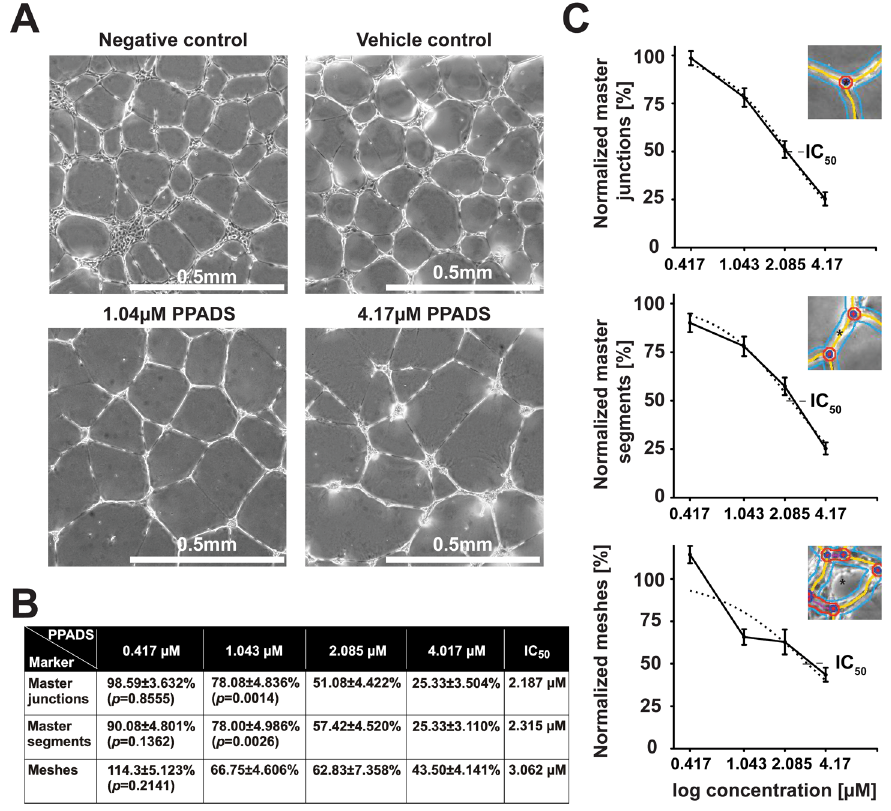
Figure 1. PPADS inhibits formation of tubes by HUVECs. A ) Representative phase contrast images of tubes formed in the absence of supplements (negative control), in the presence of vehicle (0.9% NaCl) or vehicle plus 1.04 m M PPADS or 4.17 m M PPADS. B ) Tabular summary of mean values 6 SEM of master junctions, master segments and meshes in cells incubated with the indicated concentration of PPADS and calculated IC 50 for each marker. C ) Dose dependent PPADS mediated reduction of master junctions, master segments and meshes. The punctuated line indicates the extrapolated inhibition trend. IC 50 values are indicated as intercept points in the trend line. Asterisks in each inset mark an example of a measured junction, segment or mesh, respectively. Studies were performed a total of 4 times in triplicate.